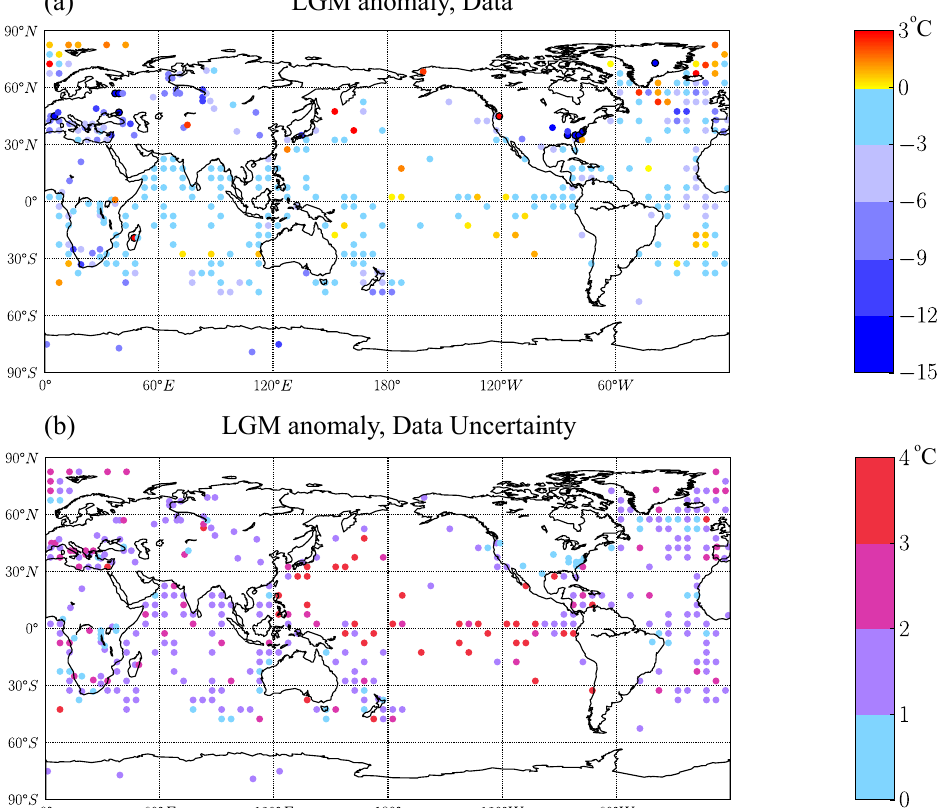
Fig. 1. (a) LGM temperature anomaly for the proxy reconstructions described in Sect. 2.1. The colorbar axes are chosen to best display the data. The actual minimum and maximum are − 16 ◦ C and 6.32 ◦ C. (b) The value of the uncertainty on the annual mean included in the data synthesis. Max=6.42, Min=0.24